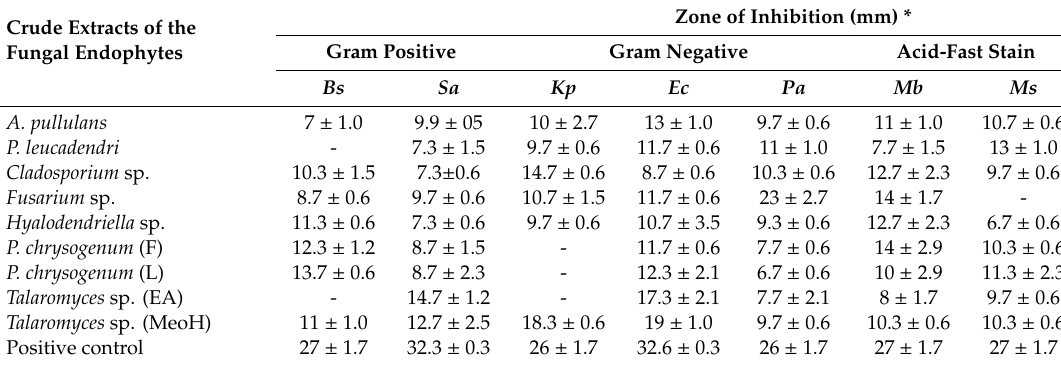
Table 4. Antimicrobial activity of the fungal endophytes isolated from Salonum mauritianum . Crude Extracts of the Fungal